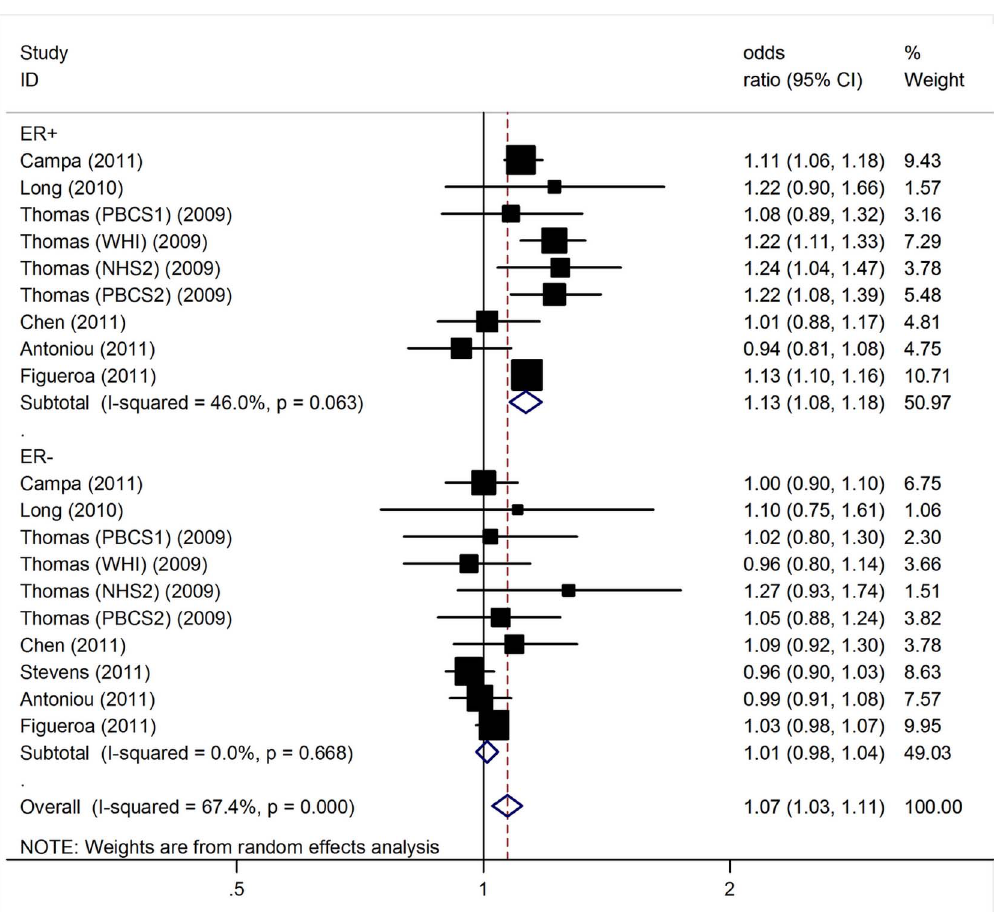
Figure 2. Per-allele odds ratios and 95% confidence intervals for the association between 1p11-rs11249433 and BC risk by ER status.